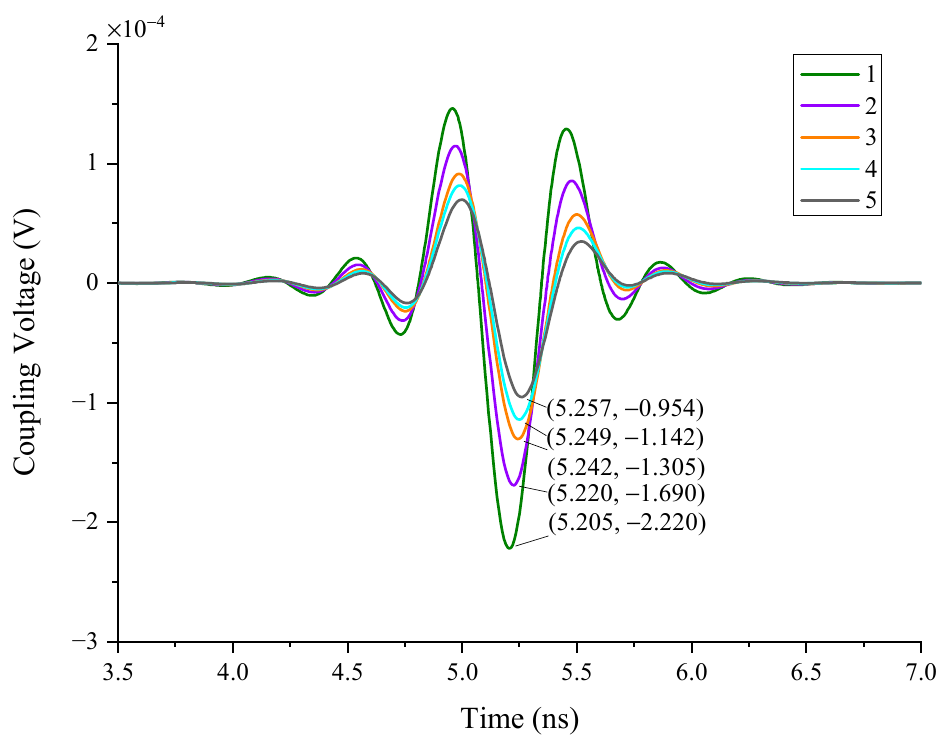
Figure 20. The responses of the different number of wires.